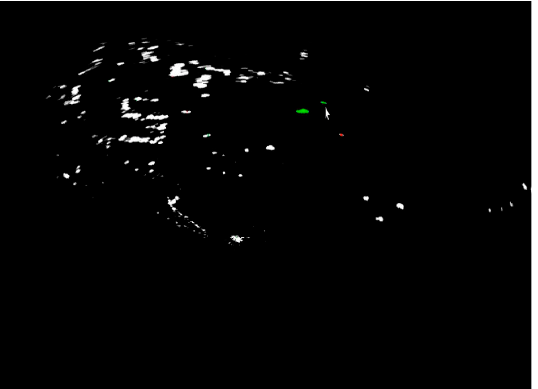
Figure 3. PPI information of vessel navigation (multiple targets).